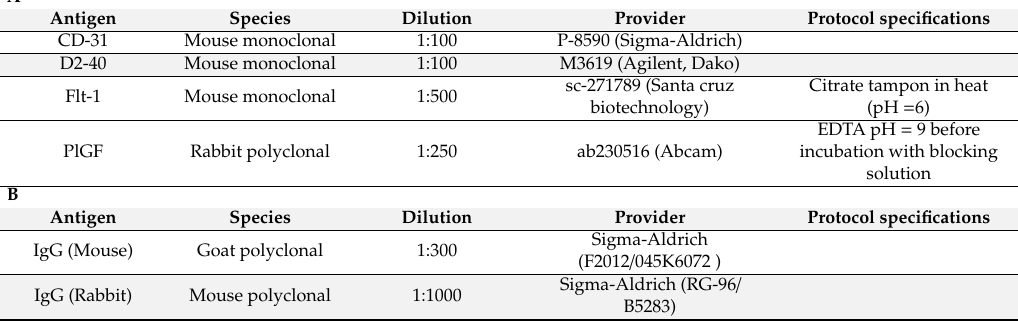
Table 2. Antibodies (A. primary, B. secondary) used in the immunohistochemical studies performed with dilutions and specifications